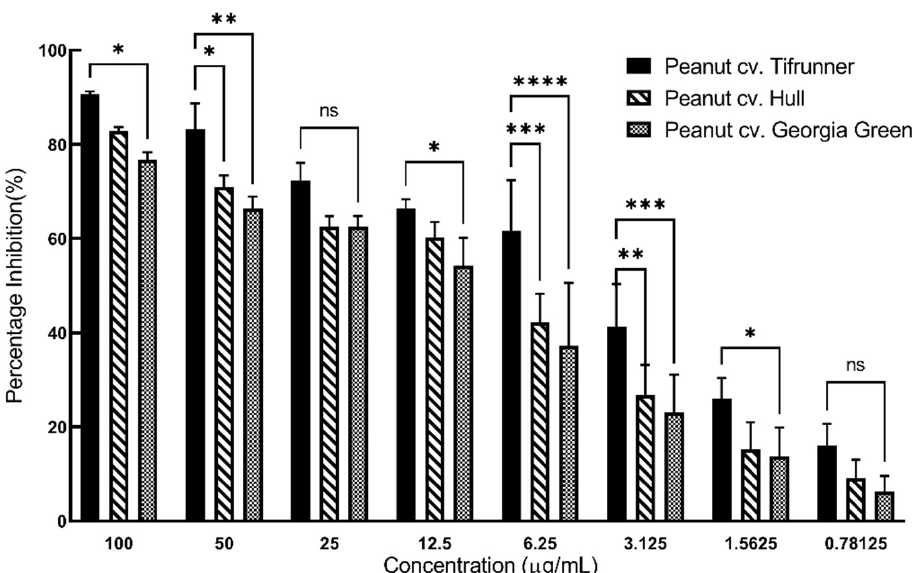
Figure 6. Comparison of total antioxidant capacity of medium extracts from hairy root cultures of peanut cultivars Tifrunner, Hull (line 3), and Georgia Green at different concentrations. Antioxidant capacity was evaluated by the DPPH assay method. Values are the average of three independent experiments, each performed in technical triplicate. Error bar represents standard deviation. Statis- tical analysis was performed with two-way ANOVA with Tukey’s multiple-comparisons test. The asterisks above the connecting line represent a significant difference when compared to the total antioxidant activity among three cultivars (*, p < 0.033; **, p < 0.002; ***, p < 0.001; ****, p < 0.0001; ns, not significant). Table 2. Amount of stilbenoid per dry weight of the extract ( µ g/mg) in three different cultivars of